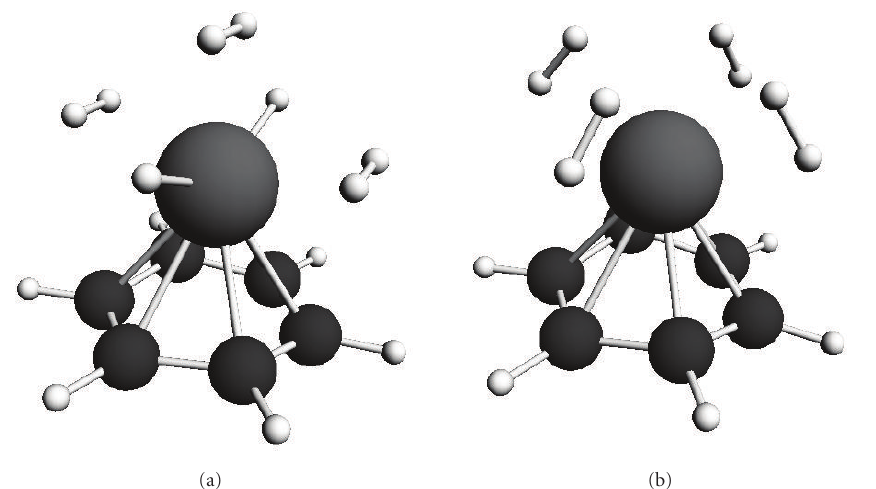
Figure 7: The two most stable four-H 2 addition patterns: (a) TiH 2 + 3H 2 and (b) Ti + 4H 2 . Hydrogen, carbon, and titanium atoms are shown in white, dark grey, and light grey,